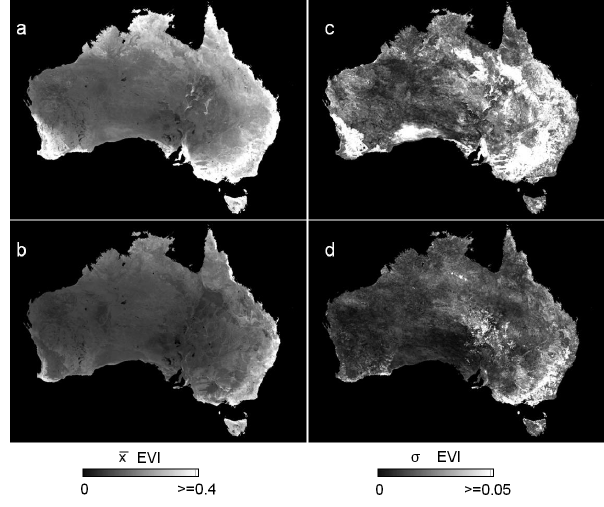
Fig 4 Figure 4. Mean of peak magnitude (a) , mean of minimum mag- nitude (b) , standard deviation of peak magnitude (c) and standard deviation of minimum magnitude (d) . A map of the dominant land cover type is provided in Fig.